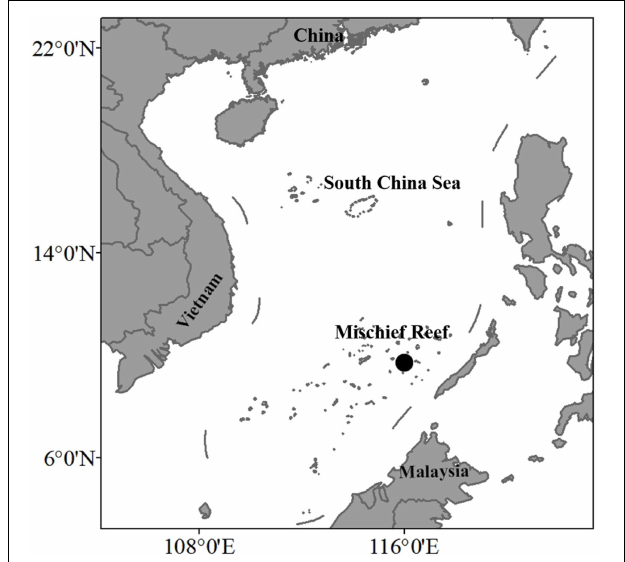
FIGURE 1 | Sampling